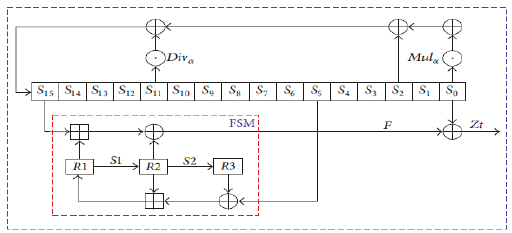
Fig. 1. Design of SNOW 3G Cipher